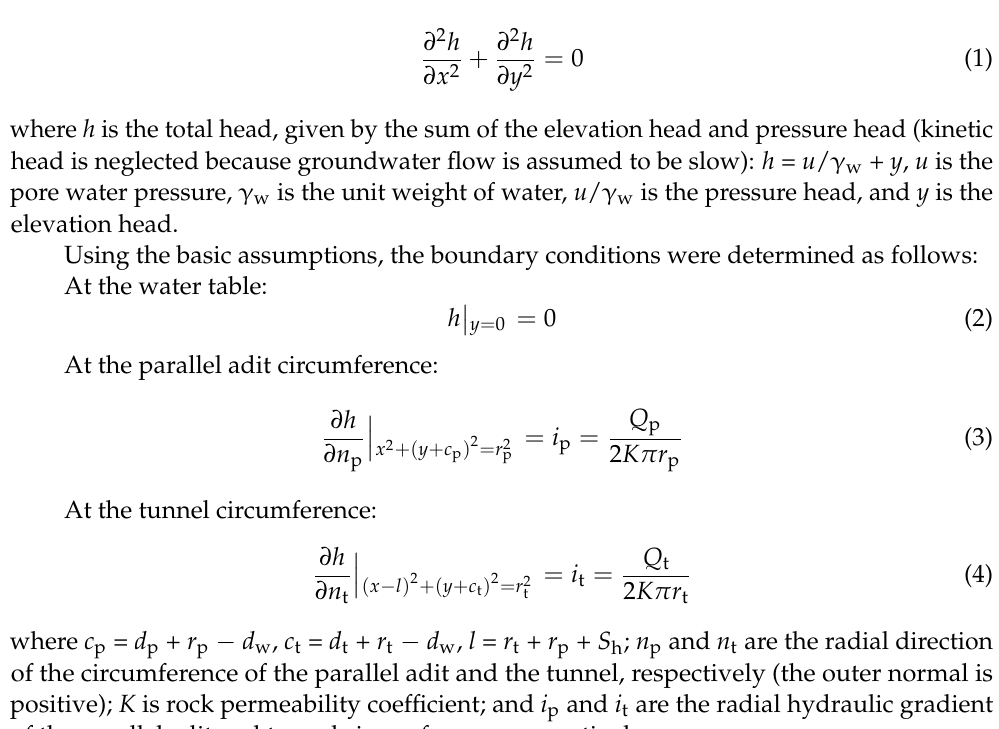
Figure 2. Simplified theoretical model of the drainage scheme for the tunnel and parallel adit. According to Darcy’s law, mass conservation law, and the above assumptions, the total head satisfies the Laplace equation: